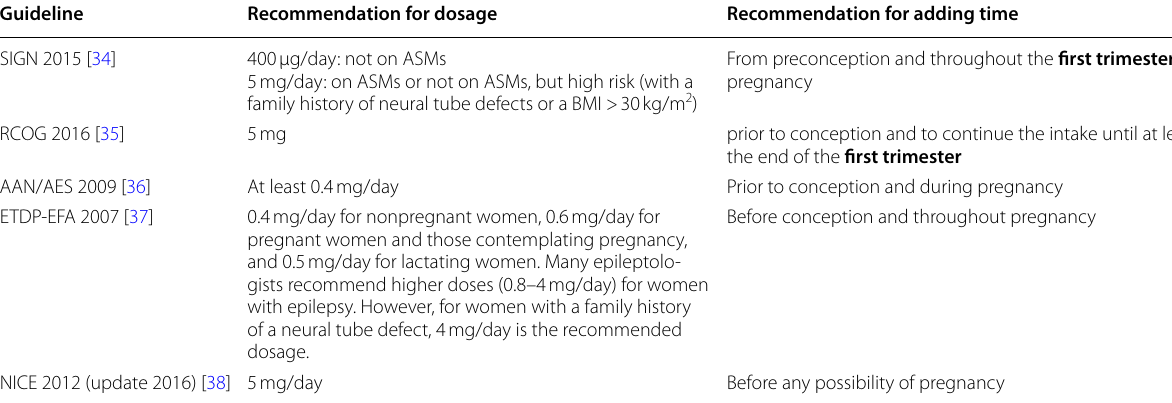
ASM Antiseizure medication, AAN American Academy of Neurology, AES American Epilepsy Society, ETPD – EFA Epilepsy Therapy Development Project – Epilepsy Foundation of America, NICE National Institute for Health and Care Excellence, RCOG Royal College of Obstetricians and Gynaecologists, SIGN Scottish Intercollegiate Guidelines Network